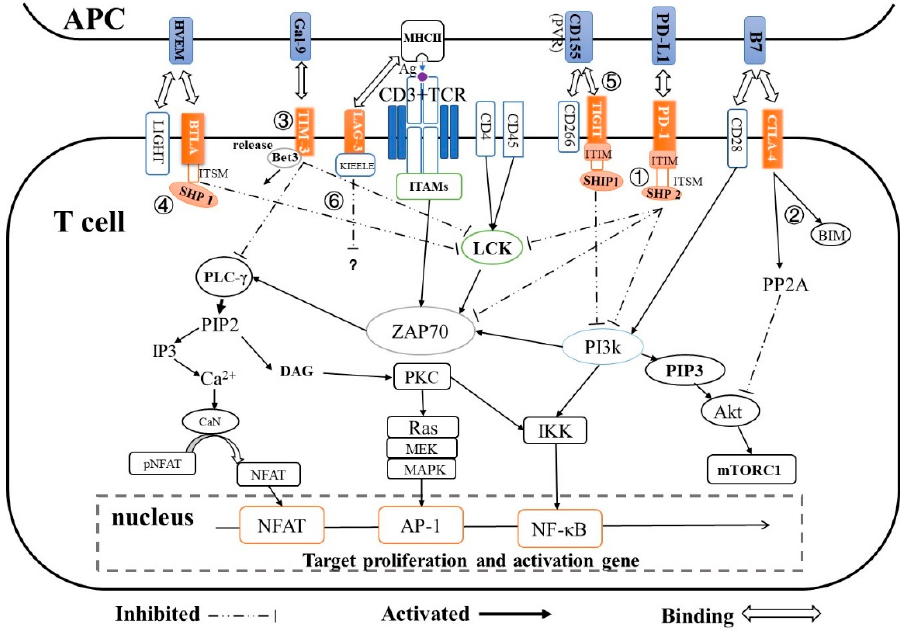
Figure 1. Mechanism of immune checkpoint ‐ mediated T ‐ cell inactivation. ① : PD ‐ 1/PD ‐ L1 inhibits